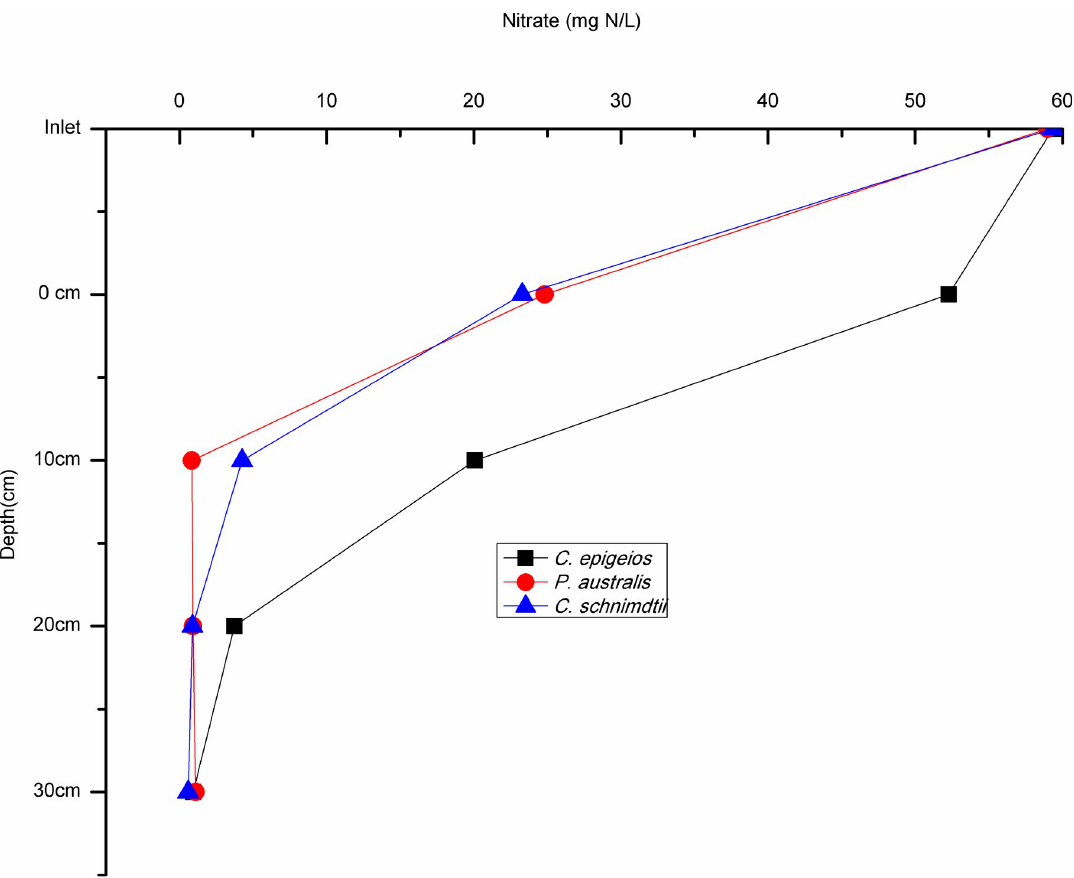
Fig 3. Nitrate concentrations at different soil depths in the soil columns from three sites dominated by different vegetation types in Qixing River Wetland National Nature Reserve.